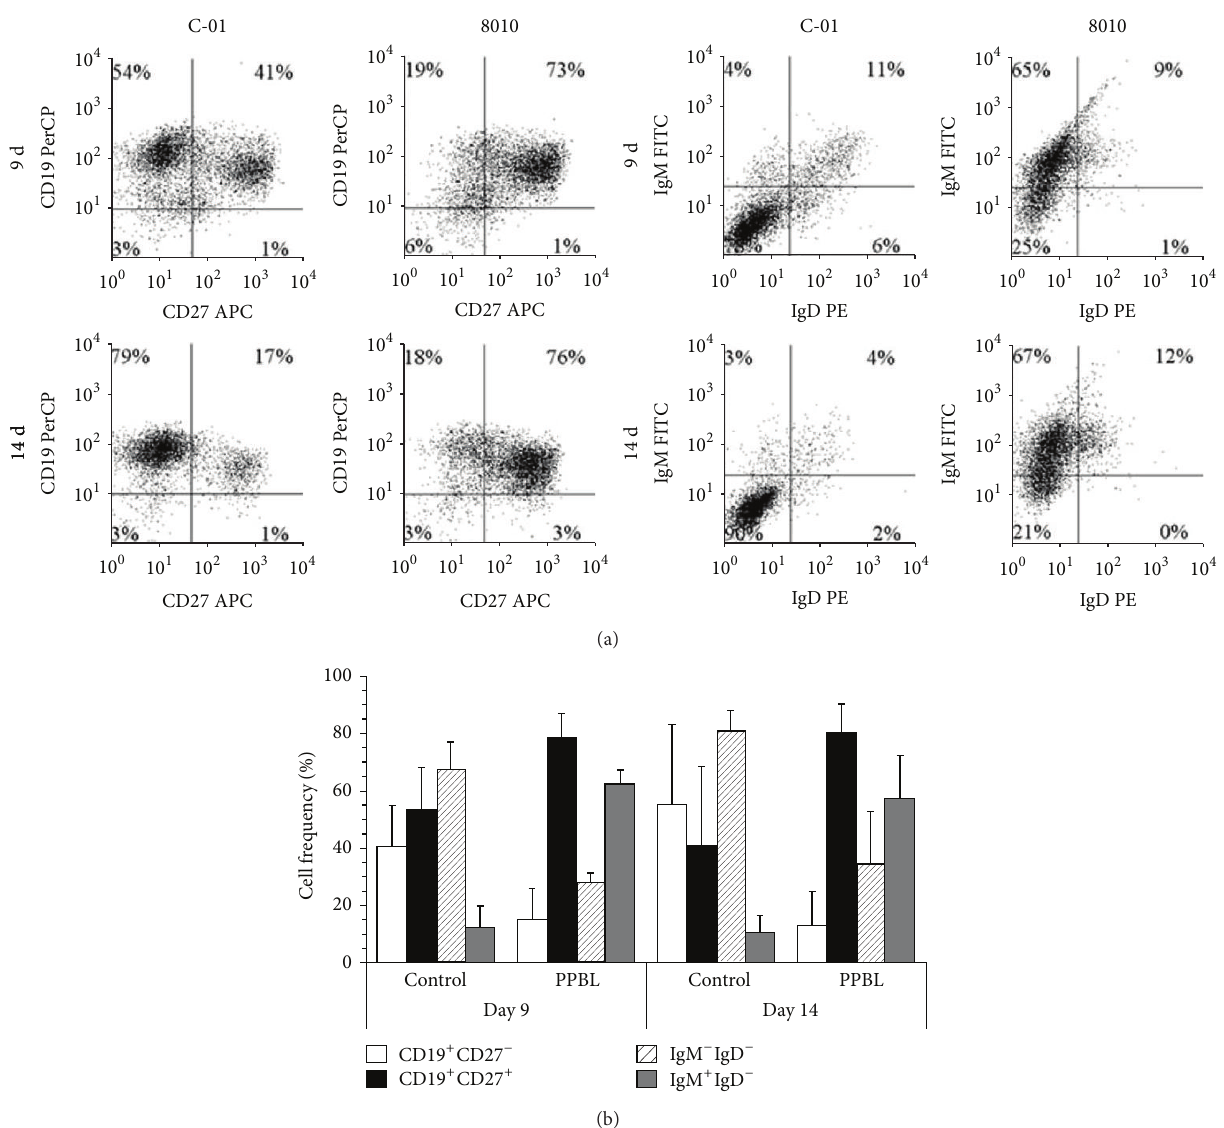
Figure 3: Phenotypes of PPBL B cells following low CD154 interaction. CD19, CD27, IgD, and IgM expressions were evaluated by flow cytometry on B cells receiving a low level of CD154 interaction (shown in Figure 2), at days 8 to 9 (9 d) or 13 to 14 (14d), as indicated. (a) Phenotypic profiles are shown for one control (C-01) and one PPBL sample (8010). (b) The frequencies of cells in the three control samples and the 6 PPBL samples are shown for the main subsets of CD19 + CD27 − , CD19 + CD27 + , IgM − IgD − , and IgM + IgD − cells, as illustrated in. (a) Data is presented as mean ±